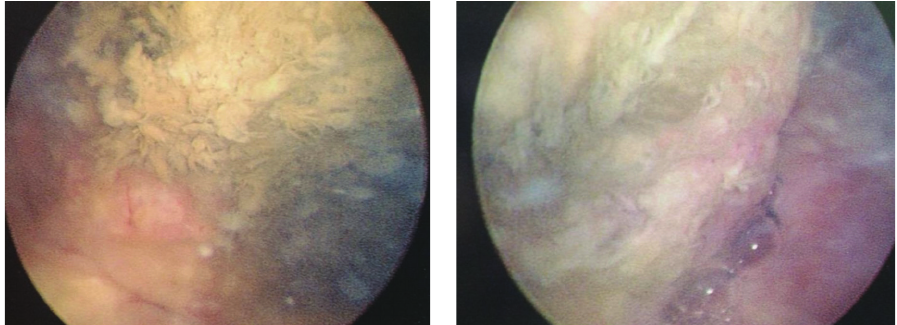
Figure 5: Preoperative cystoscopic views; we can note the necrotic aspect of the tumor on the anterior wall.